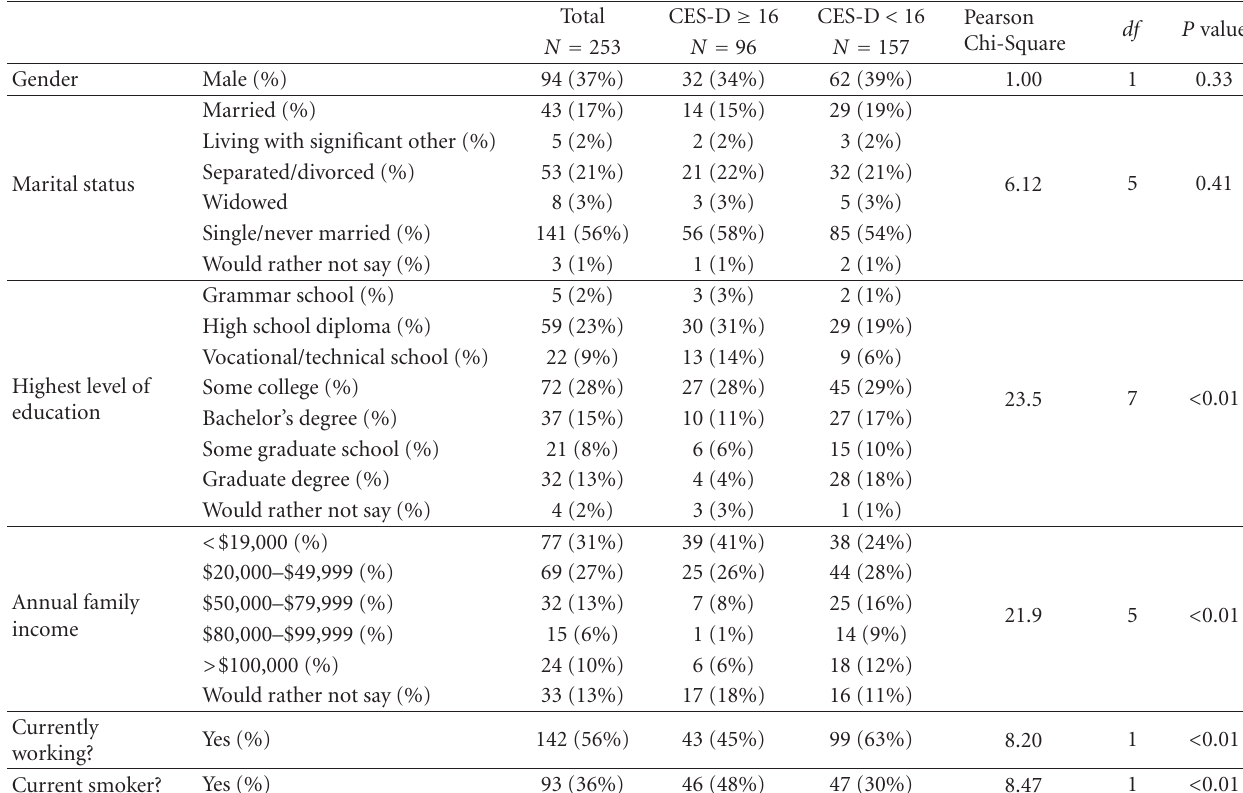
Table 1: Participant characteristics (categorical